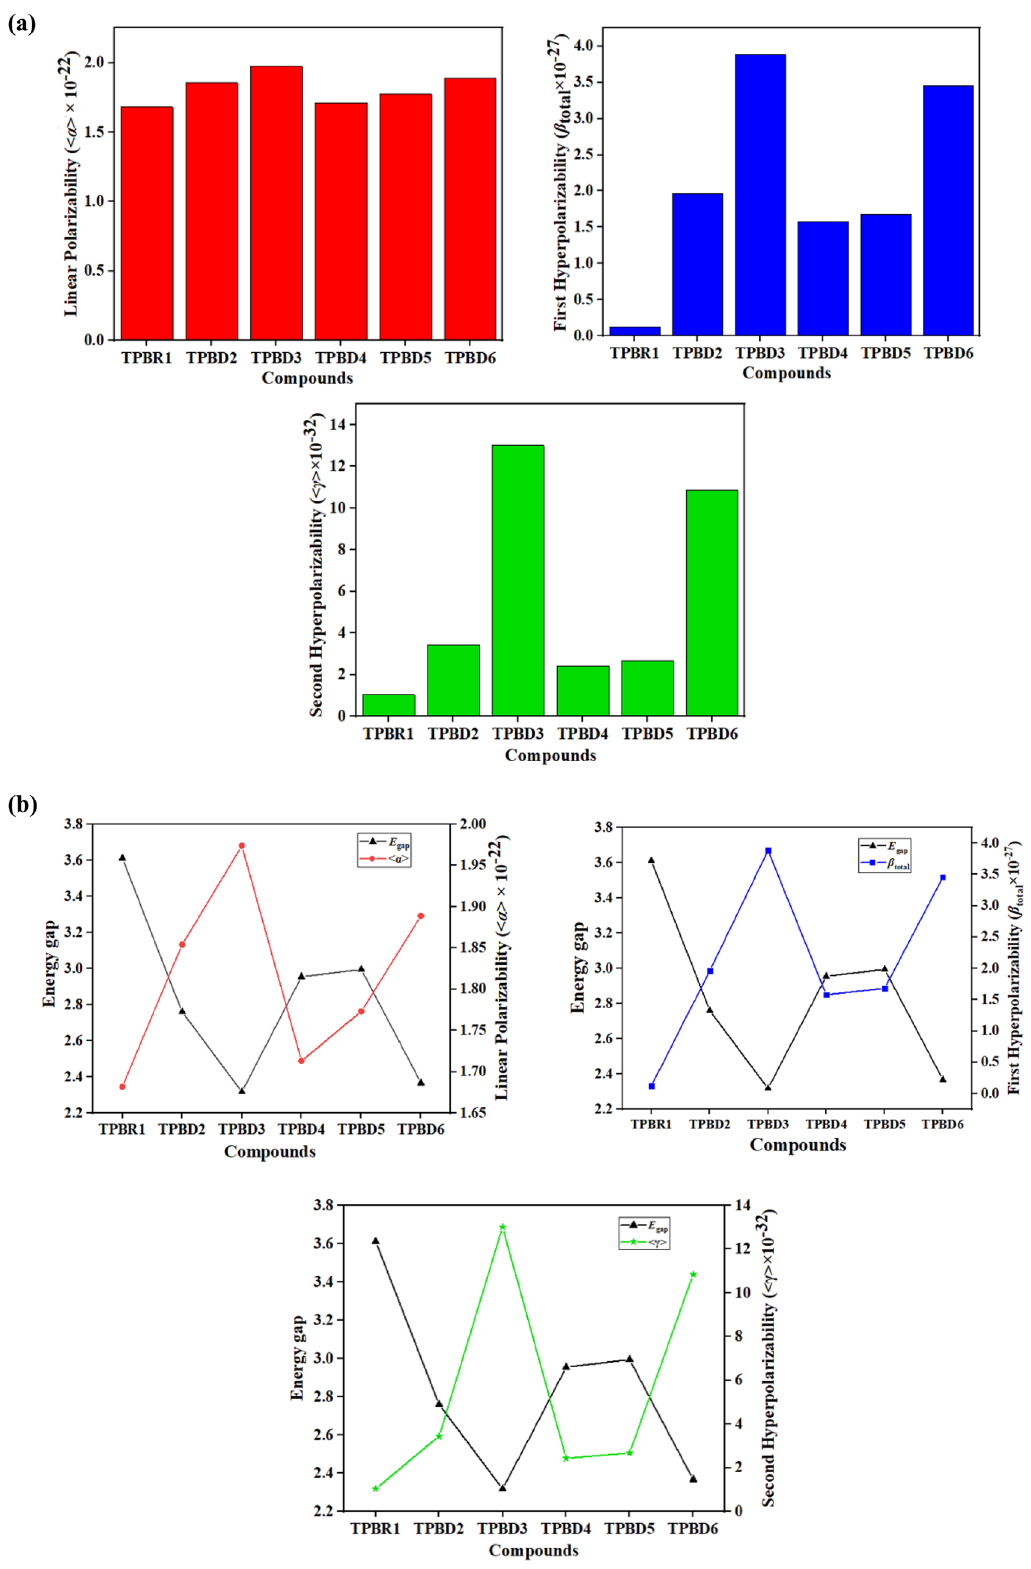
Figure 6. ( a ) Graphical representation of linear polarizability and hyperpolarizabilities of entitled compounds. These graphs are drawn by utilizing Origin Pro 8.5 version (https:// origi npro. infor mer. com/8. 5/). All out put flies of entitled compounds were computed through Gaussian 09 version D.01 (https:// gauss ian. com/ g09ci tation/). ( b ) A comparison of <a> , β total , γ total with energy band gap ( E HOMO − LUMO ) of TPBR1 and TPBD2-TPBD6 . These graphs are drawn by utilizing Origin Pro 8.5 version (https:// origi npro. infor mer. com/8. 5/). All out put flies of entitled compounds were computed through Gaussian 09 version D.01 (https:// gauss ian. com/ g09ci